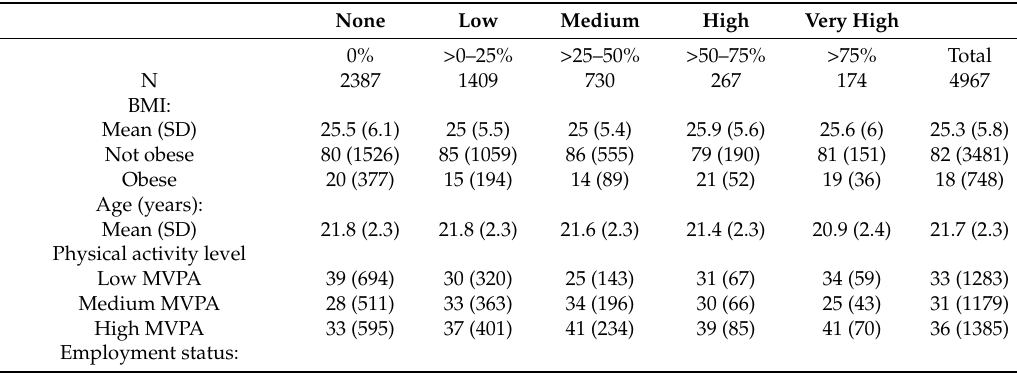
Table 4. Characteristics of the sample from the combined 2008–2014 HSE and SHS survey, by percentage of recommended daily allowance for energy from alcoholic beverages consumed by individuals on their heaviest drinking day (% RDA Energy) for